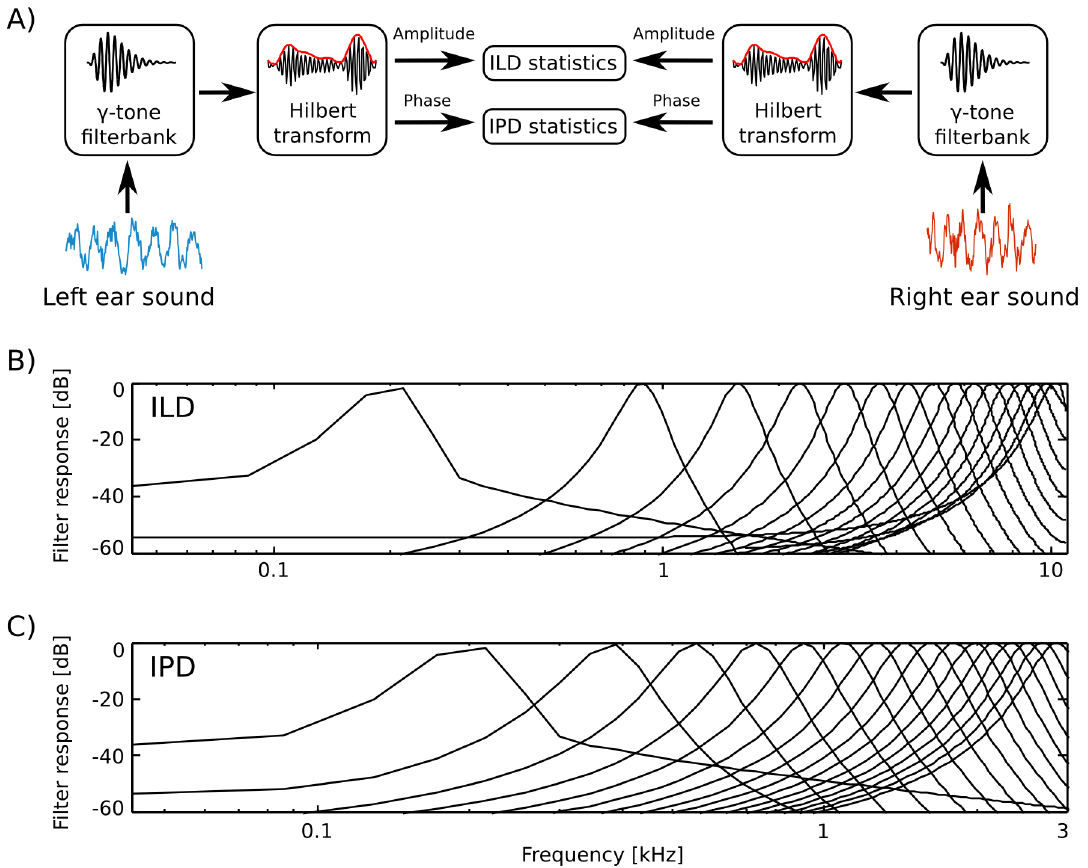
Figure 1. Preprocessing and cue extraction pipeline. A) Preprocessing scheme. Raw sounds in each ear were tranformed using a cochleotopic filterbank. In the next step the Hilbert transform was computed to separate amplitude from phase. Finally IPDs and ILDs were extracted. B) Filter response spectra of 16 out of 64 filters used to extract interaural level differences. C) Filter response spectra of 16 out of 64 filters used to extract interaural phase differences.